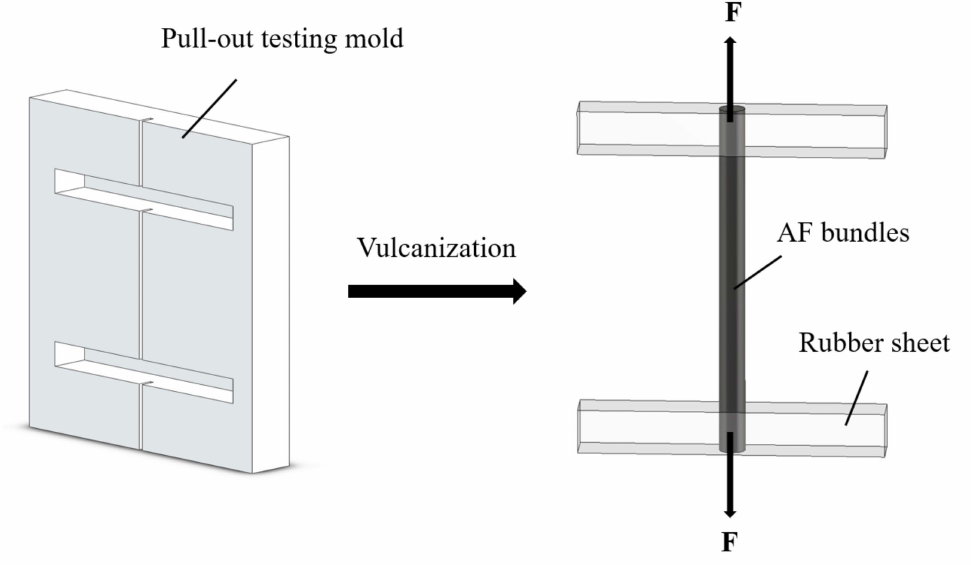
Figure 2. Schematic illustration of the preparation and pull-out test for AF/rubber